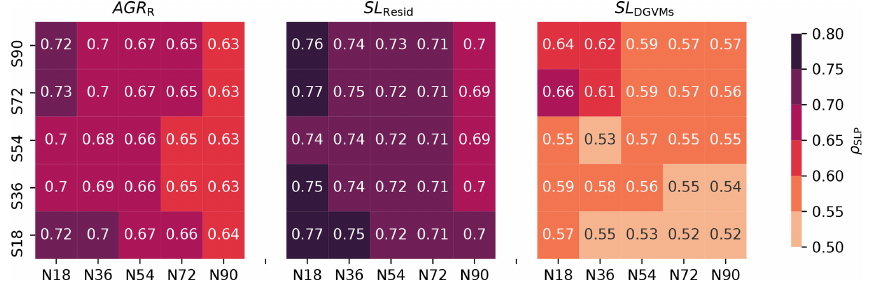
Figure A6. Heat map of ρ SLP with CO 2 time series over various SLP latitude domains in DJF. Each heat map contains 5 × 5 squares, and each square represents one domain of SLP. For example, the square 36 ◦ N–72 ◦ S is the domain of SLP extending from 36 ◦ N to 72 ◦ S. All latitudinal domains include the tropical area (18 ◦ N–18 ◦ S). The top right square thus represents global-scale SLP. ρ SLP of AGR R , SL Resid , and SL DGVMs in